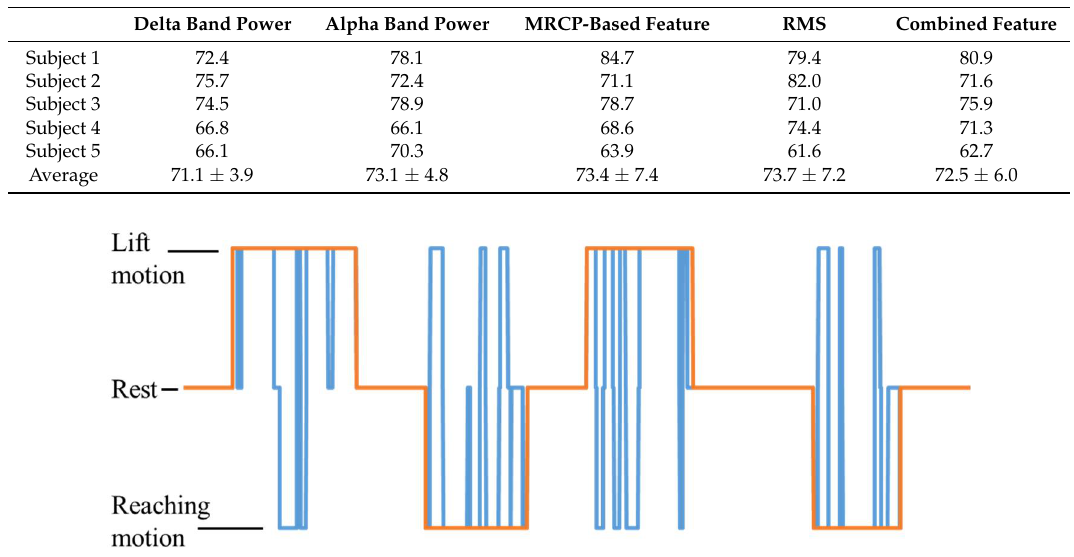
Table 3. Summarized results for five subjects with neural networks (accuracy percentage).